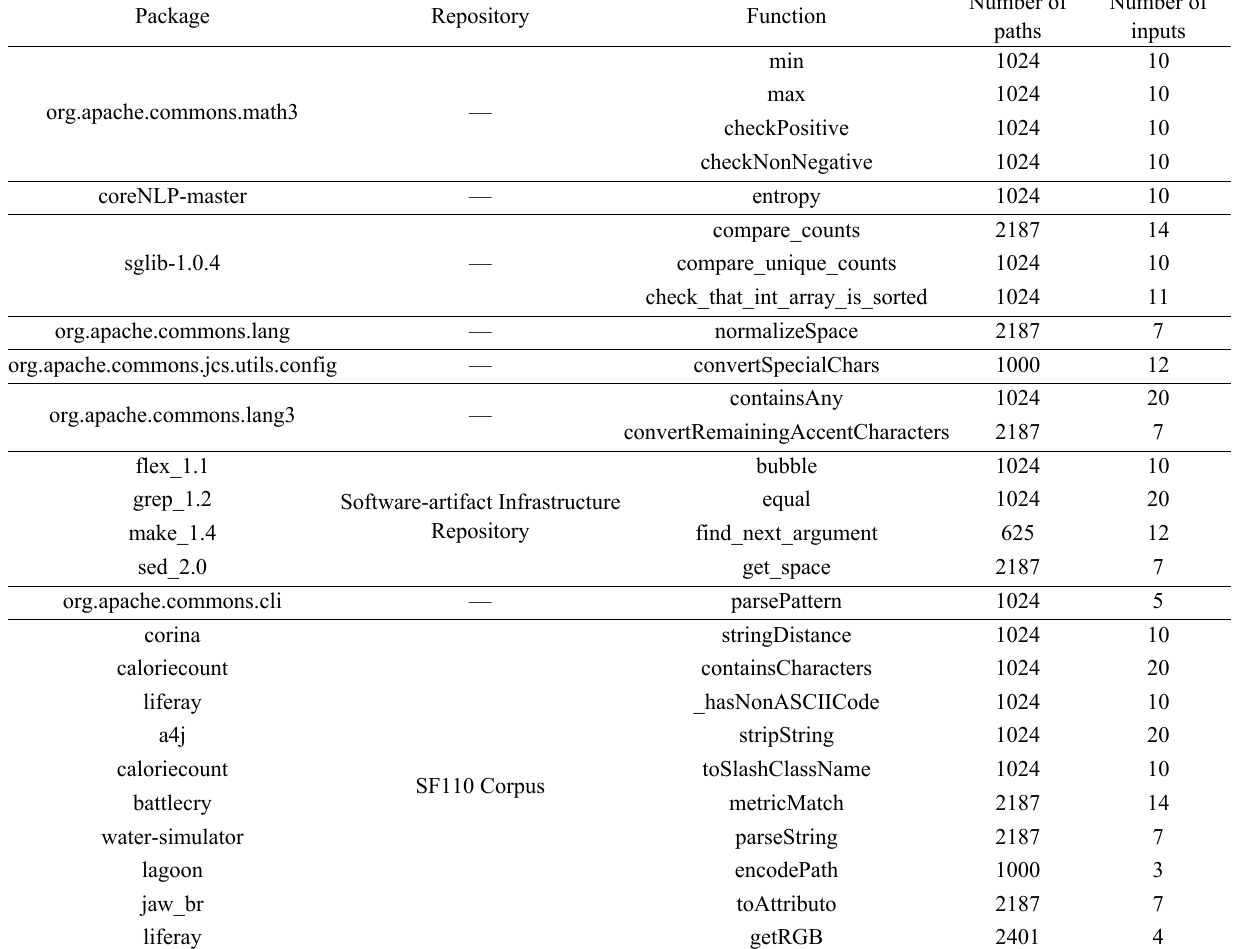
Table 1 Details of the subjects under study.